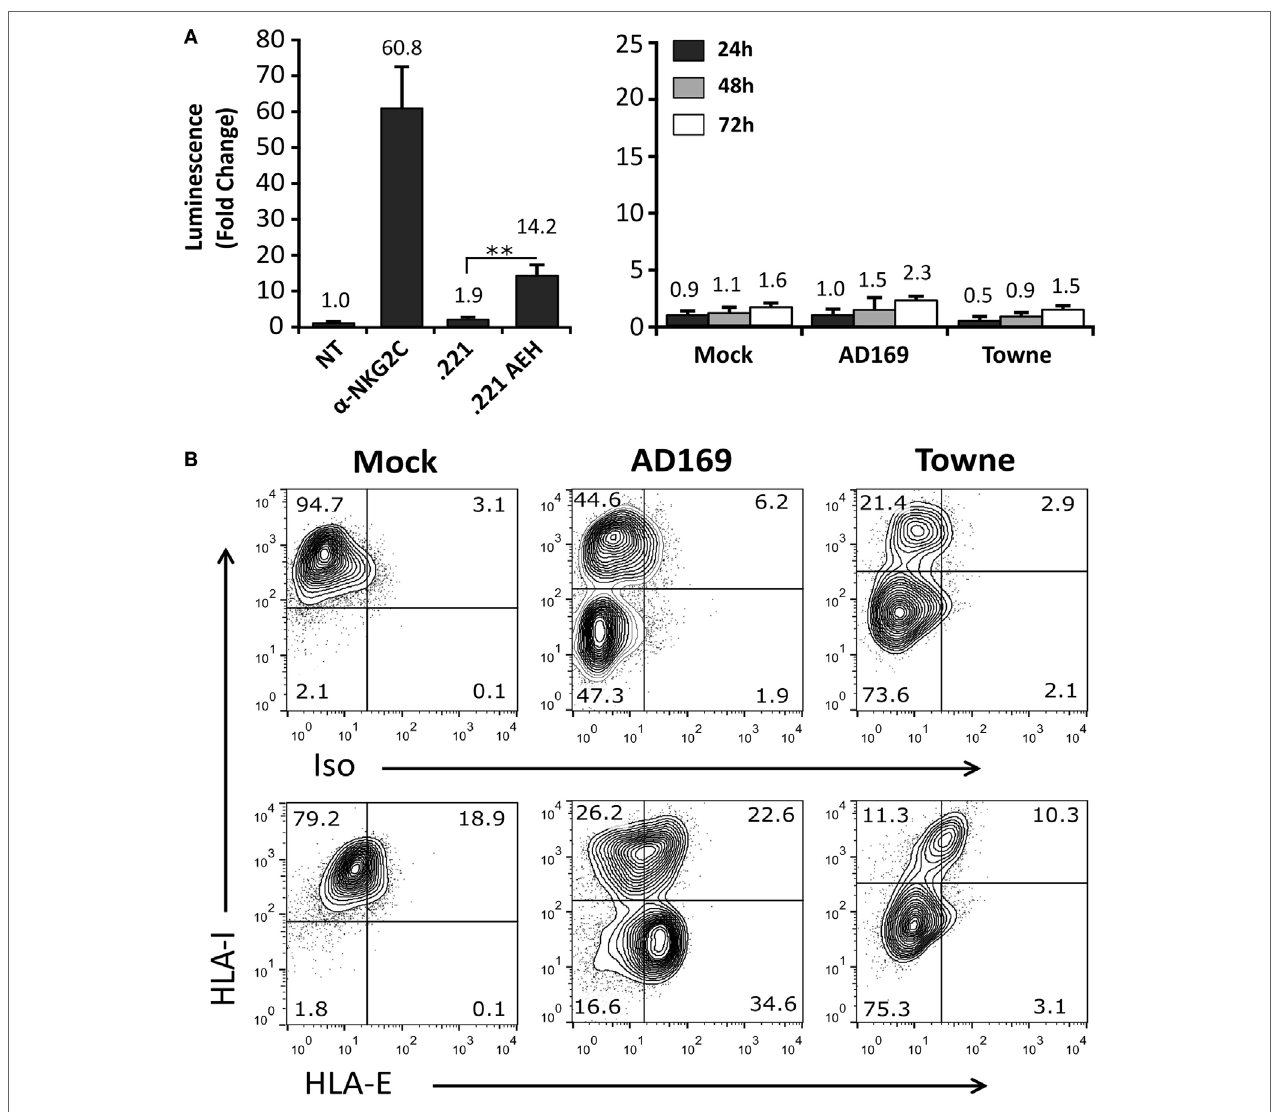
FigUre 4 | Cells infected with AD169 or Towne human cytomegalovirus (HCMV) strains do not activate the Jurkat-NKG2C + reporter independently of HLA-E expression. (a) HFFF cells infected with AD169 or Towne HCMV strains (multiplicity of infection = 10) were cocultured at 24, 48, and 72 h postinfection with Jurkat-NKG2C + cells electroporated with the reporter plasmid. The average infection rate for each experiment was > 50%. As a control, reporter activation following CD94/NKG2C receptor engagement by specific monoclonal antibodies or HLA-E was assessed in parallel, as described in Figure 2 . Data correspond to three independent experiments (mean ± SD). (B) Total HLA-I and HLA-E expression at 72 h postinfection in mock-treated and HCMV-infected HFFF cells. Statistically significant differences are indicated (** p <